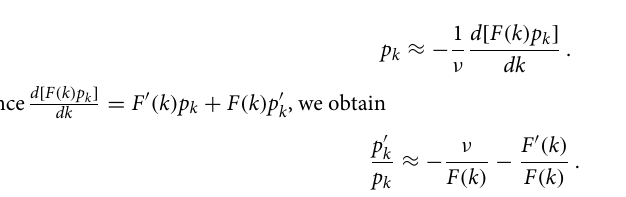
Figure 6. Frequency distribution of inter-event time steps between pairs of consecutive occurrences of the same color: (Up, Left) Migration; (Up, Right) COVID-19; (Below) Simulations of the model with F given by 2 , ν 0.75 , ρ and different values of ρ and z ρ (13), N 0 = = = (cid:31)